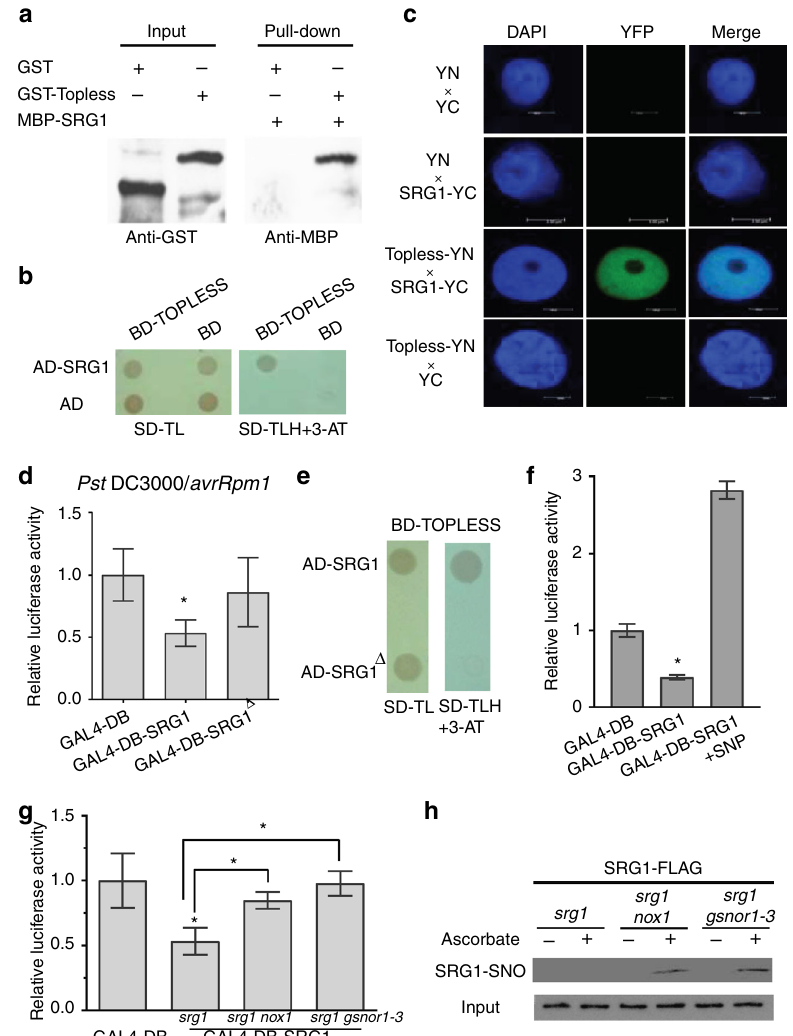
Fig. 4 NO negatively regulates SRG1 transcriptional repression. a Recombinant myelin basic protein (MBP)-SRG1 interacts with glutathione S-transferase (GST) tagged Topless corepressor in an in-vitro pull-down assay, as indicated in western blot analysis utilizing either anti-MBP or anti-GST antibodies. b SRG1 interacts with Topless in a yeast two-hybrid assay. AD, Gal4 activation domain; BD, GAL4 DNA-binding domain. Transformed yeast were spotted on selective medium SD-TL or SD-TLH (SD-TLH, synthetic dextrose medium lacking leucine, tryptophan and histidine) with 5 mM 3-amino-1,2,4 triazole (3AT). c In planta interaction of SRG1 and Topless established a by bimolecular fl uorescence complementation (BiFC) assay in Nicotiana benthamiana leaves. Topless was fused to the N-terminus of yellow fl uorescent protein (YFP) to form Topless-YN and SRG1 was fused to the C-terminus of YFP forming SRG-YC. These proteins were then simultaneously transiently expressed in N. benthamiana leaves by agroin fi ltration. In planta interaction of Topless-YN and SRG-YC enables YFP-dependent fl uorescence imaged by confocal microscopy. Scale bar, 5 μ m. d Relative luciferase activity was measured after cotransformation of reporter plasmids together with an effector plasmid, comprised of either the GAL4 DNA-binding domain (DB) (GAL4-DB), GAL4- SRG1-DB or GAL4-DB-SRG1 △ (SRG1 △ , deletion of EAR domain of SRG1) into srg1 protoplasts. Values are mean ± SD ( n = 3). Star indicates signi fi